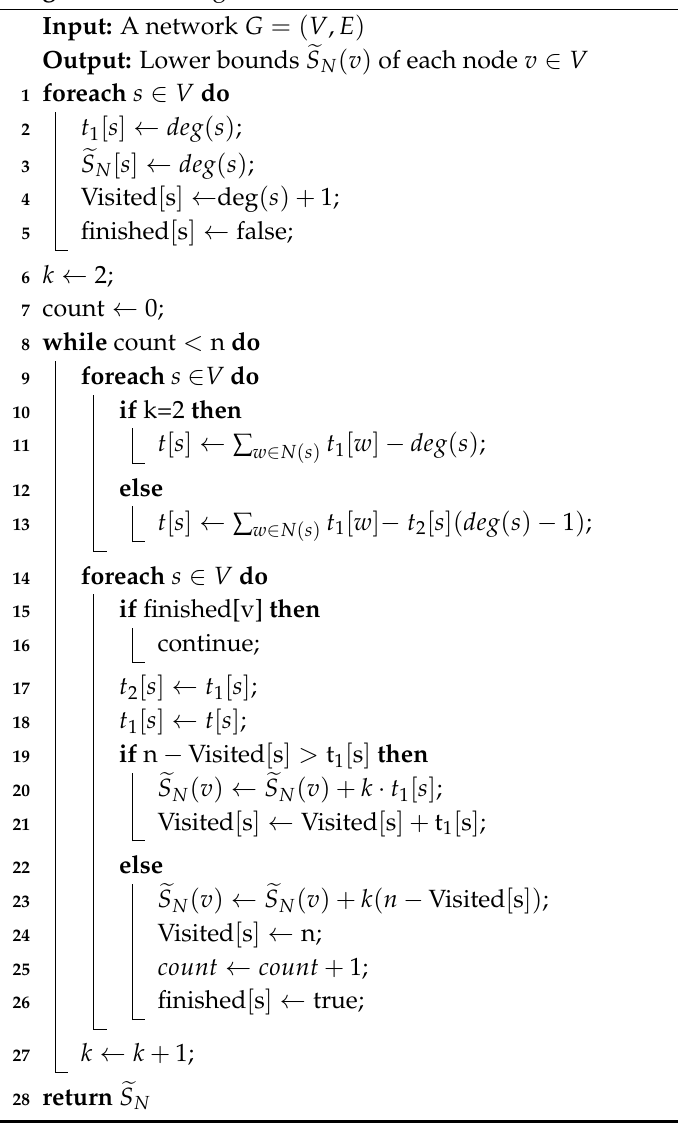
Algorithm 8: Neighborhood-based lower bound for undirected